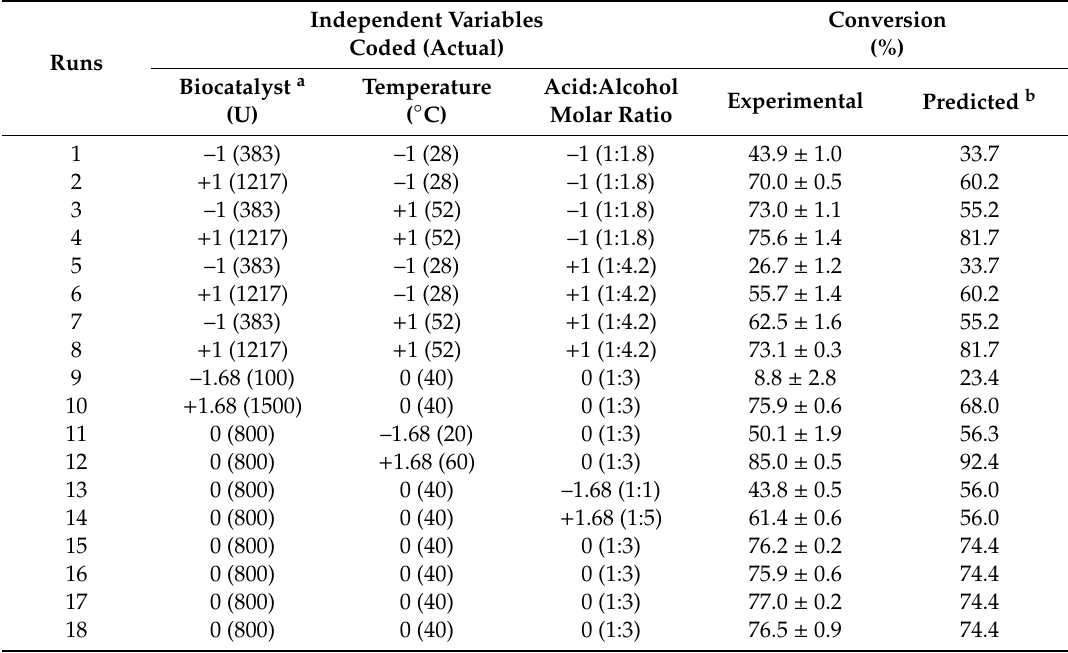
Table 2. Central Composite Rotatable Design (CCRD) matrix for the analysis of the influence of independents variables on the ester synthesis catalyzed by TLL–Octyl–SiO 2